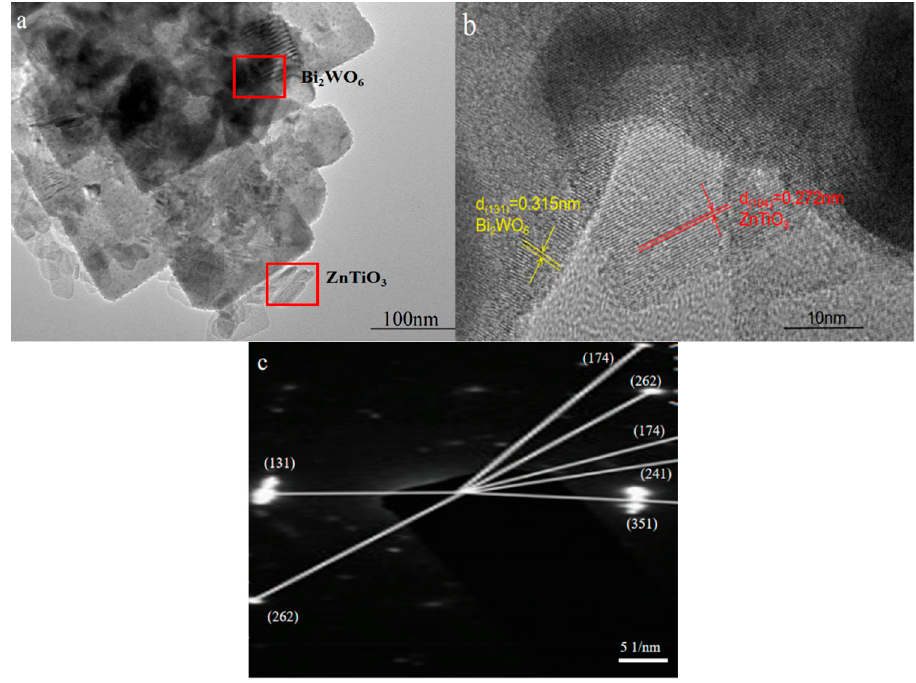
Figure 3. ( a ) TEM image, ( b ) HRTEM image, and ( c ) SAED pattern of the ZnTiO 3 /Bi 2 WO 6 hetero- junction sample.